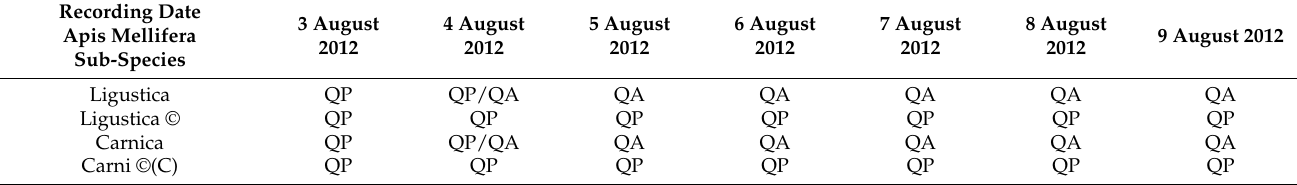
Table 1. The status of each of the four hives for the 7 days of recording of the first (Arnia Ltd.) dataset. C stands for control group, QA for Queen Absent and QP for Queen Present. The QP/QA entries indicates that the queen was removed from that hive around midday that day. Aug stands for August.